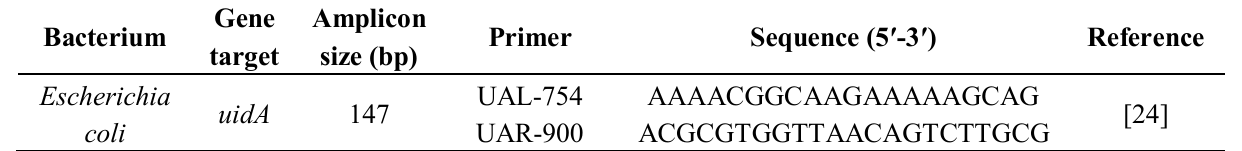
Table 3. PCR oligonucleotide primers used to detect E.coli